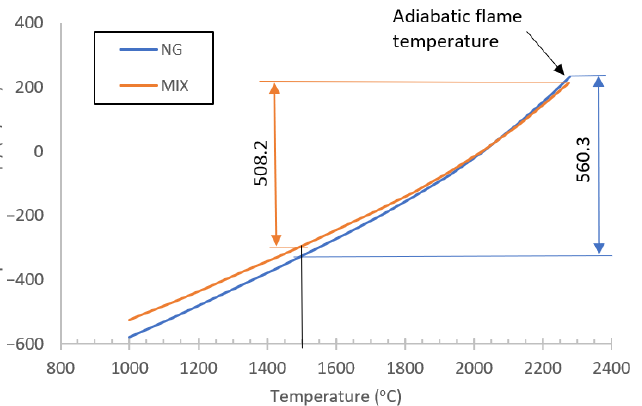
Figure 7. Enthalpy of combustion gases as function of temperature (T furnace = 1500 °C; SC = 1.10; T air = 1000 °C).